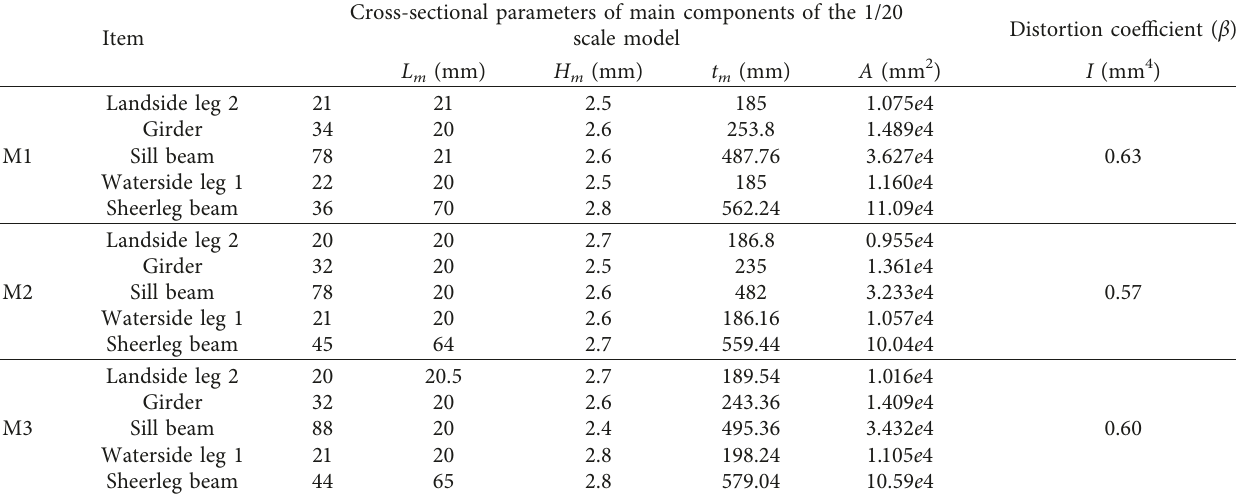
Table 3: Cross-sectional parameters of distortion components.